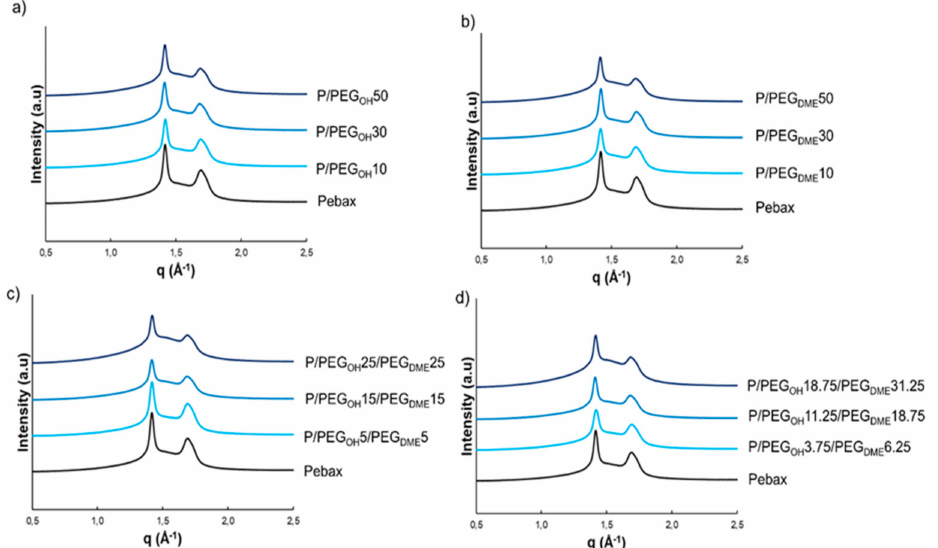
Figure 5. Resulting WAXS patterns of pristine Pebax ® and Pebax ® /PEG blends: Pebax ® /PEG OH blends ( a ), Pebax ® /PEG DME blends ( b ), Pebax ® /PEG OH /PEG DME blends with a 50/50 PEG OH /PEG DME weight ratio ( c ), and Pebax ® /PEG OH /PEG DME blends with a 37.5/62.5 PEG OH /PEG DME weight ratio ( d ). Curves were shifted vertically for